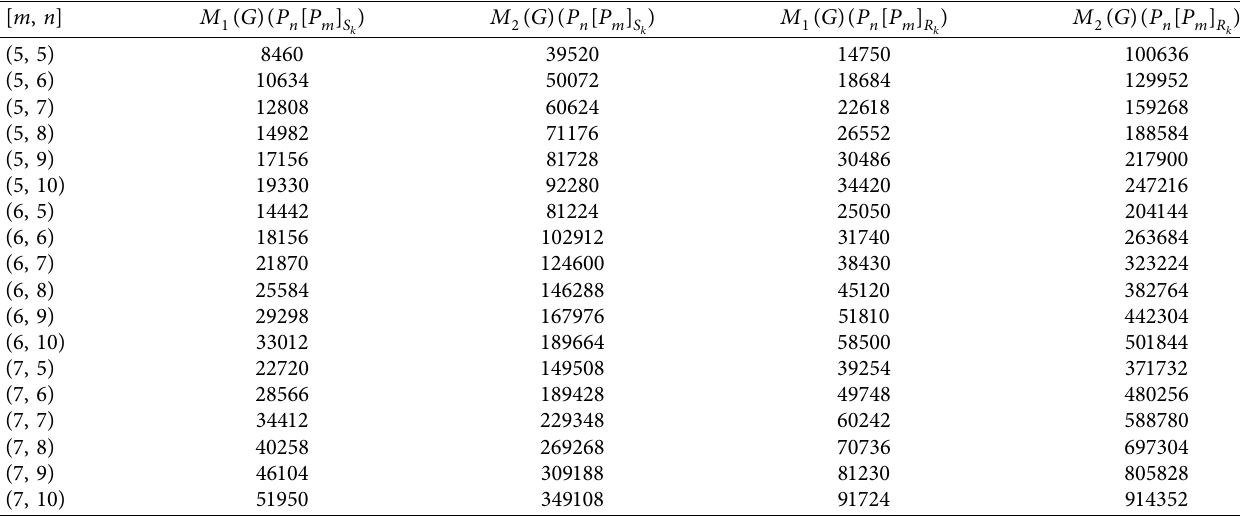
[ P ] ) for k � n m N k